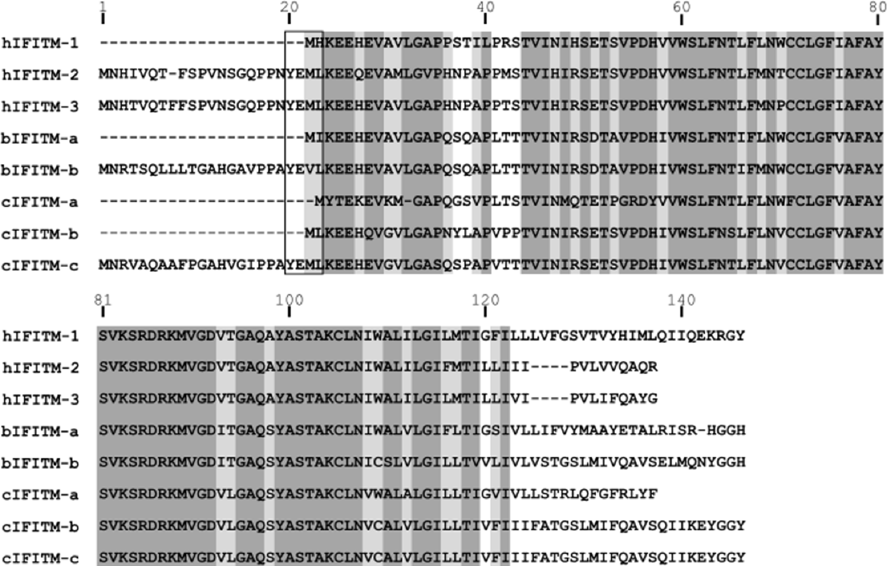
Figure 1. Sequence alignment of human, bovine, and camel IFITMs. The alignment was performed using MUltiple Sequence Comparison (MUSCLE) software. Aligned amino acids are highlighted in dark or light grey depending on whether the residue is present in at least 80% or 50% of the sequences, respectively. Note that shorter N-terminal domains are characterized by the absence of the YXX φ motif (rectangle) present in hIFITM-3 as well as in other IFITMs. hIFITM-1, human IFITM-1; hIFITM-2, human IFITM-2; hIFITM-3, human IFITM-3; bIFITM-a, bovine IFITM-a; bIFITM-b, bovine